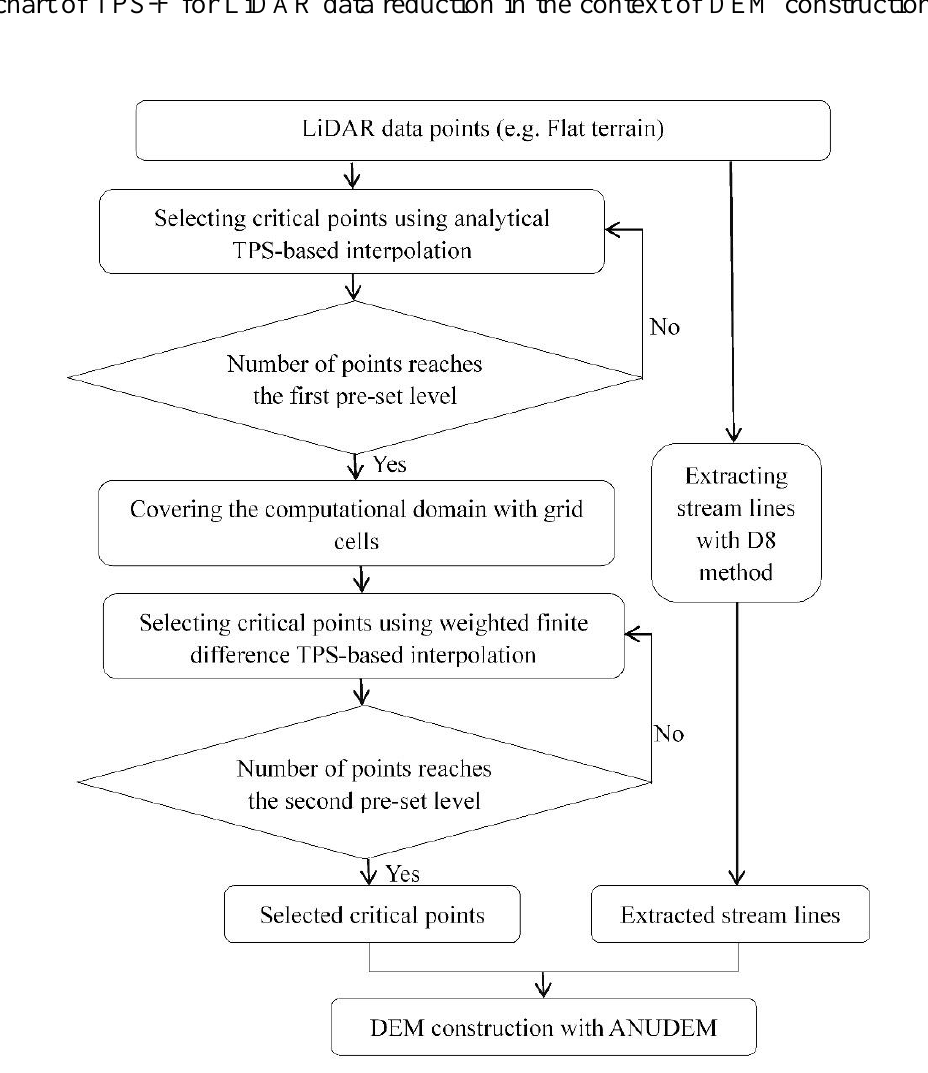
Figure 1. Flow chart of TPS-F for LiDAR data reduction in the context of DEM